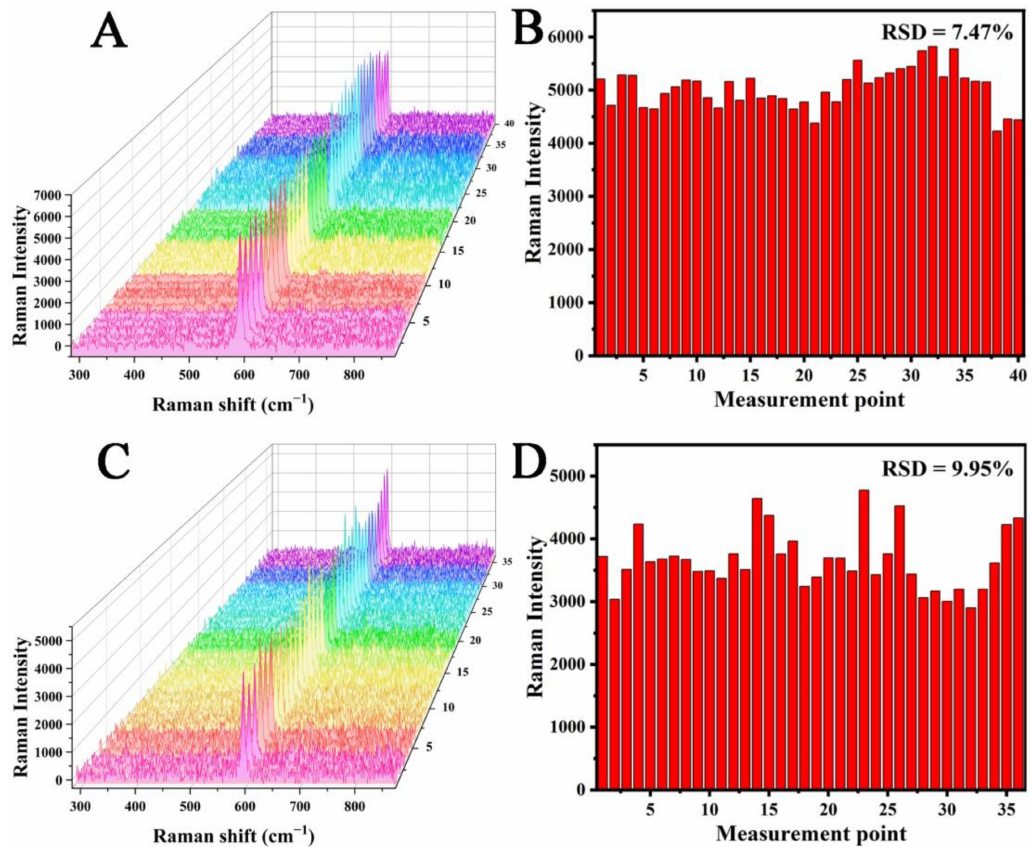
Figure 4. ( A ) SERS spectra of a 10 − 6 M NBA solution acquired at 40 spots on the MC/Ag NPs film. ( B ) SERS intensity of NBA at 590 cm − 1 from 40 random points. ( C ) SERS spectra of a 10 − 6 M NBA solution acquired at 36 spots on the MC/Ag NPs film after incubation for two months at room temperature. ( D ) SERS intensity of NBA at 590 cm − 1 from 36 random